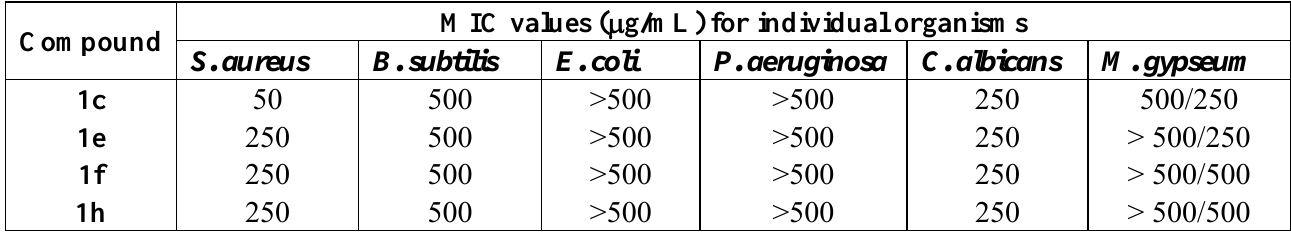
Table 1. The quantitative antibacterial and antifungal activities of new benzothiazole- N -oxides.